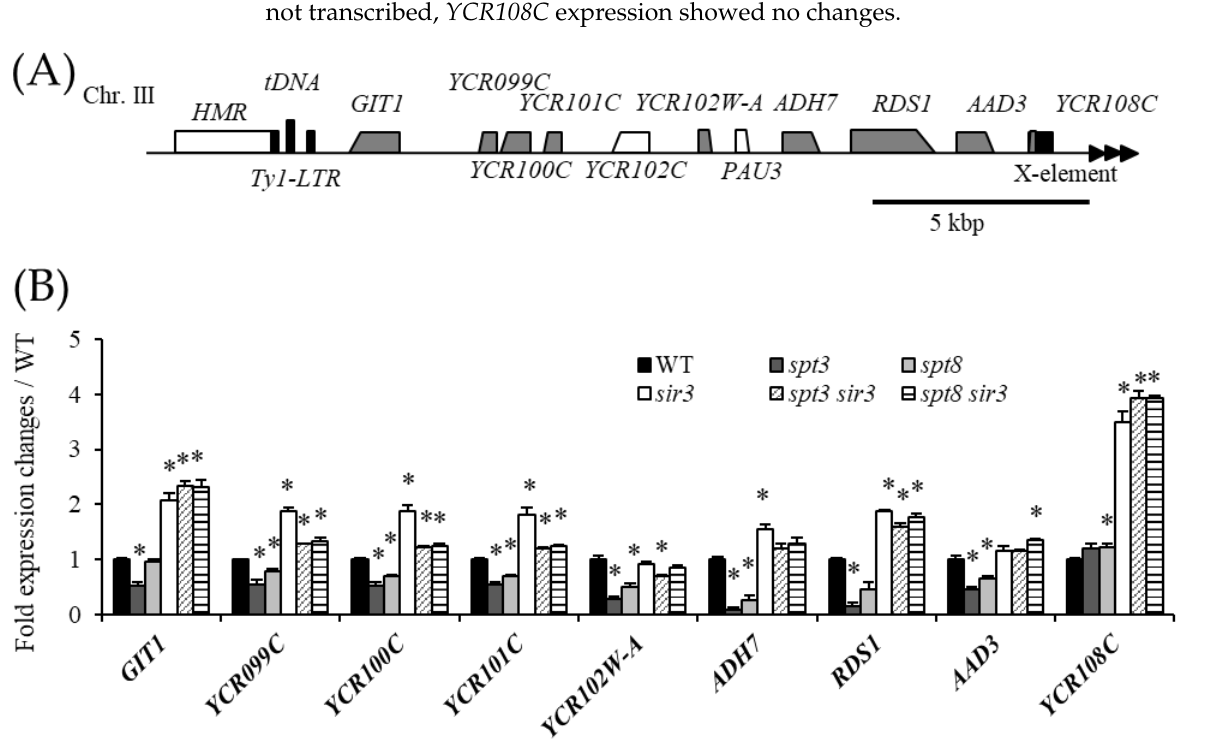
Figure 3. Spt3 and Spt8 are involved in boundary formation. ( A ) Gene map of Chr IIIR. Grey genes were measured gene expression. ( B ) Transcription level at Chr IIIR genes in the spt3 ∆ strain and spt8 ∆ strain, and in the sir3 ∆ strain by RT-qPCR. Asterisks mean p < 0.05 compared with WT (Student’s T-test). Error bars show standard errors calculated from three independent experiments.